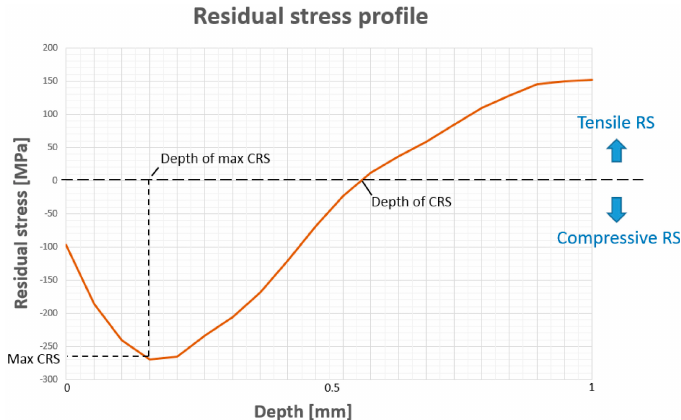
Figure 10. Residual stress profile displaying the most relevant parameters: Max CRS—maximum amount of CRS; Depth of max CRS—depth at which the maximum CRS is observed; Depth of CRS—depth at which a transition from CRS to tensile residual stress (TRS) occurs [33].